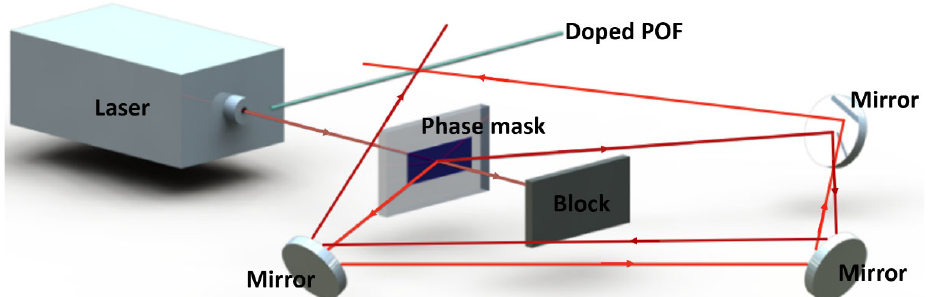
Figure 11. The diagram of inscription system based on Signac optical ring interference. Additionally, researchers use the laser and phase mask technique to inscribe FBGs,